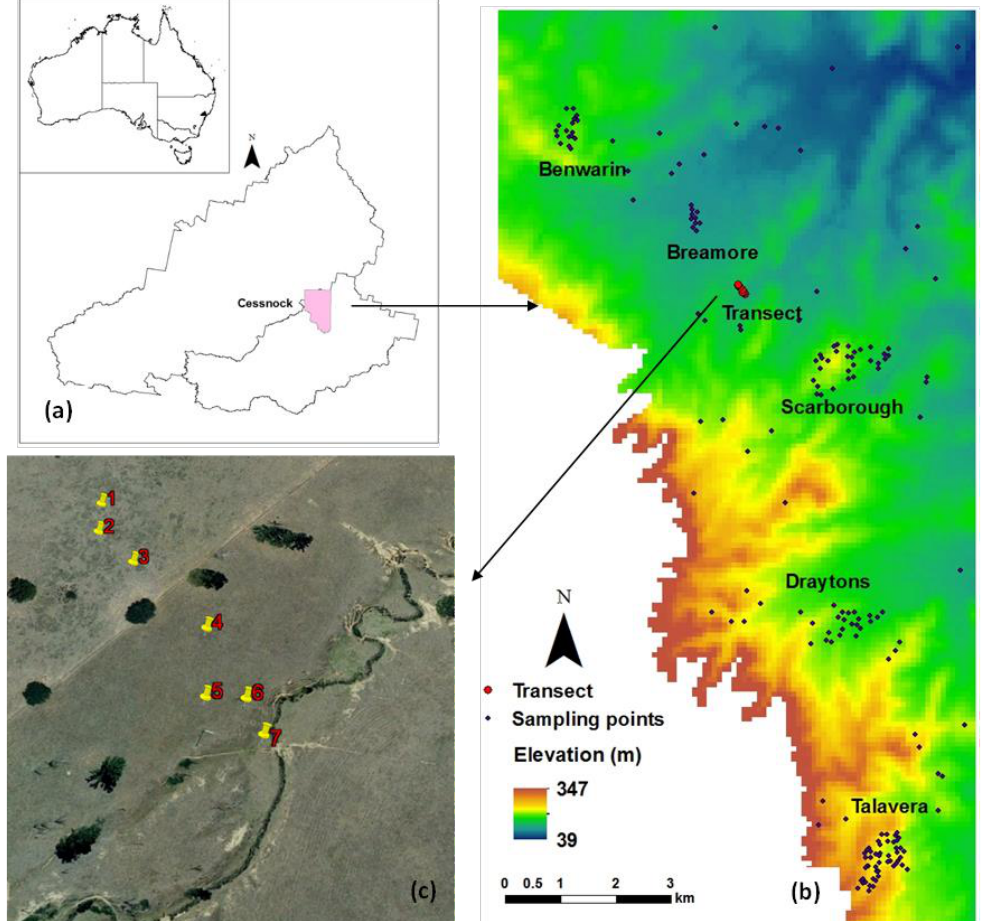
Figure 1. Location map of the study area. Panel ( a ) shows the location of the sub-area of the HWCPID. Panel ( b ) shows the elevation of the study area and sampling points in the whole area and five vineyards. Panel ( c ) shows the seven cores from a transect in a vineyard.